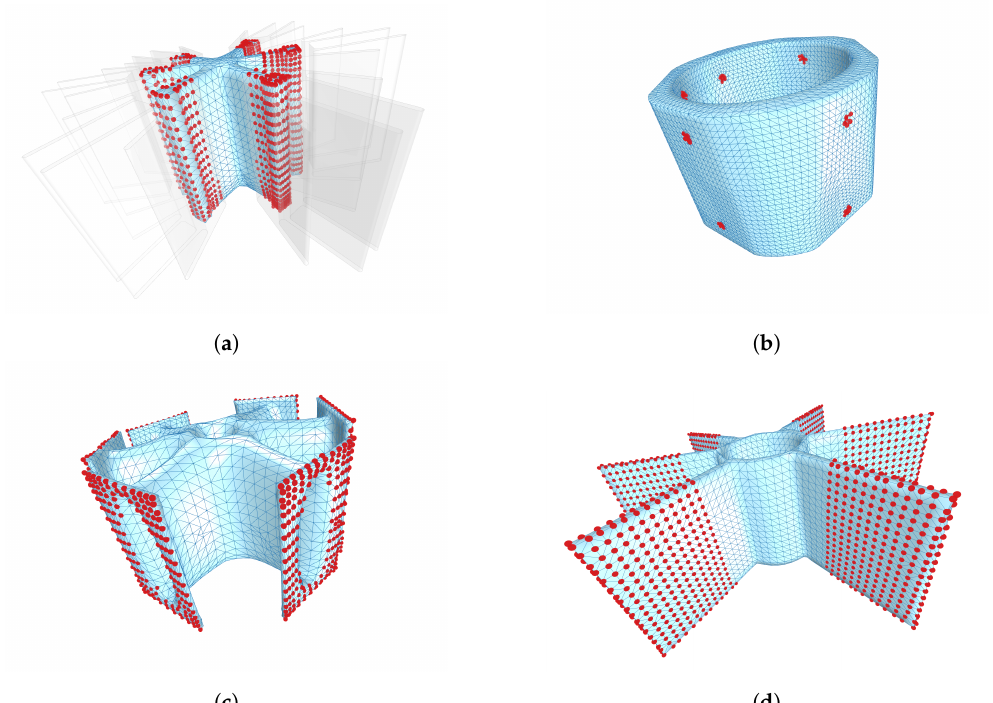
Figure 12. Meshed versions of the four node proposals. Red dots indicate positions where loads or boundary conditions are applied. ( a ) Meshed Glued Finger Node. ( b ) Meshed Mero ZK. ( c ) Meshed Starnode. ( d ) Meshed